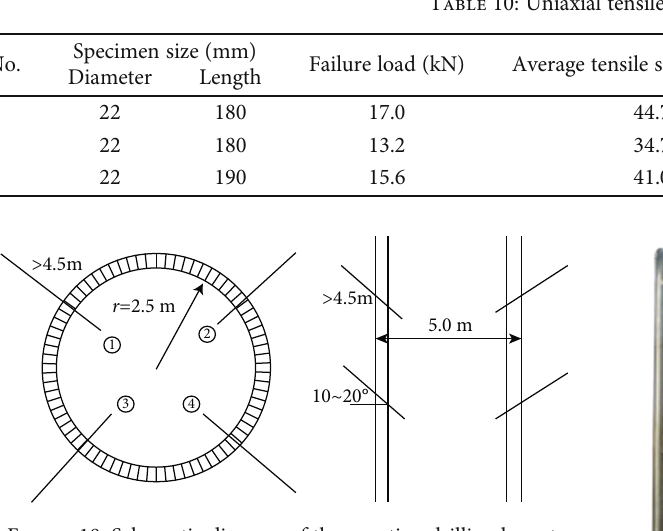
Figure 18: Schematic diagram of the grouting drilling layout.